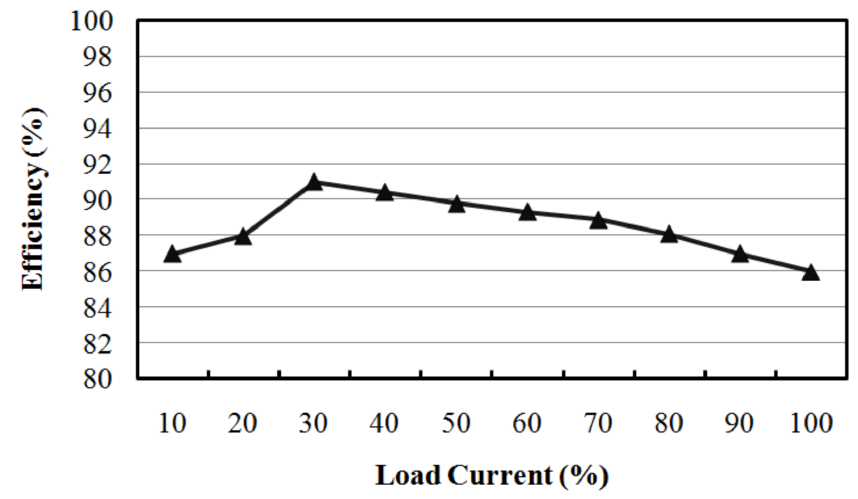
Figure 26. Curve of efficiency versus load current at the same load current percentage for three